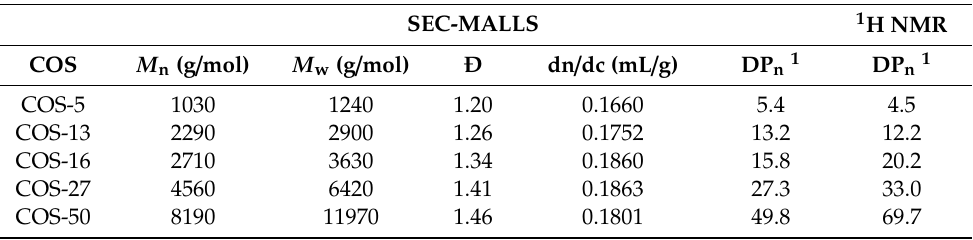
Table 1. Chitosan oligosaccharides (COS) characterization by SEC-MALLS and nuclear magnetic resonance (NMR)